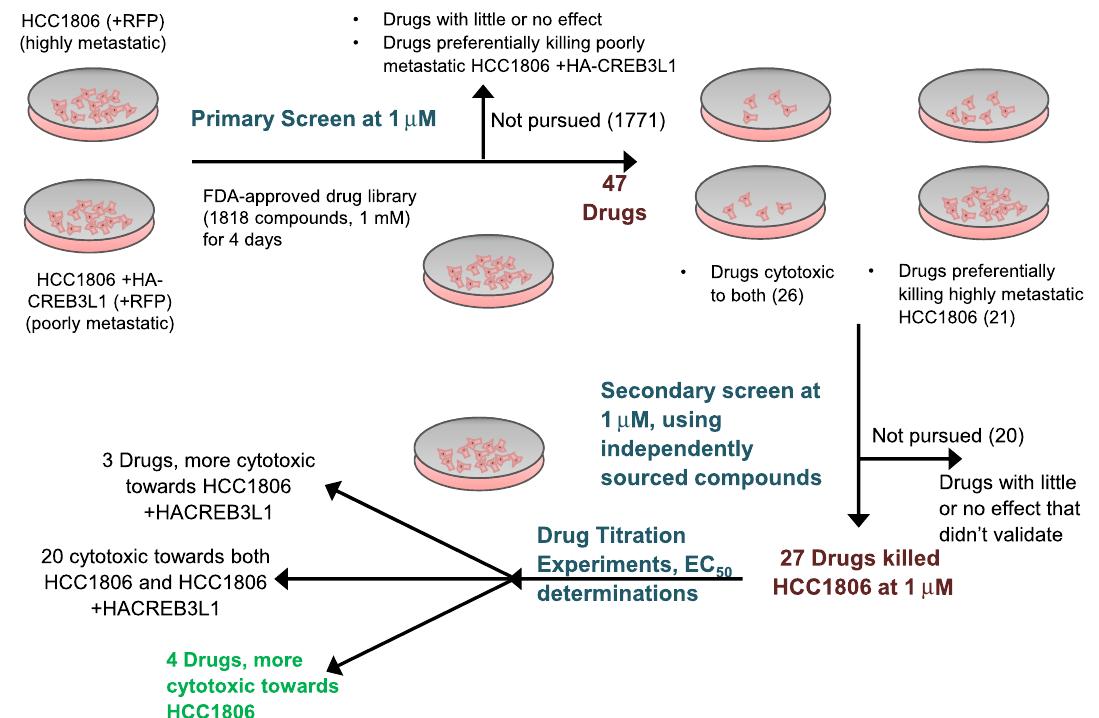
Figure 1. Primary and secondary drug screen schematic. Details are described within the